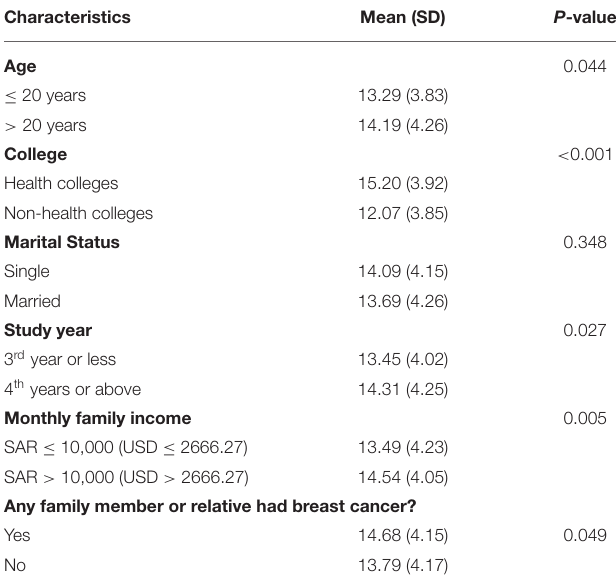
TABLE 5 | Mean difference in BC knowledge score among participant groups ( N = 506).